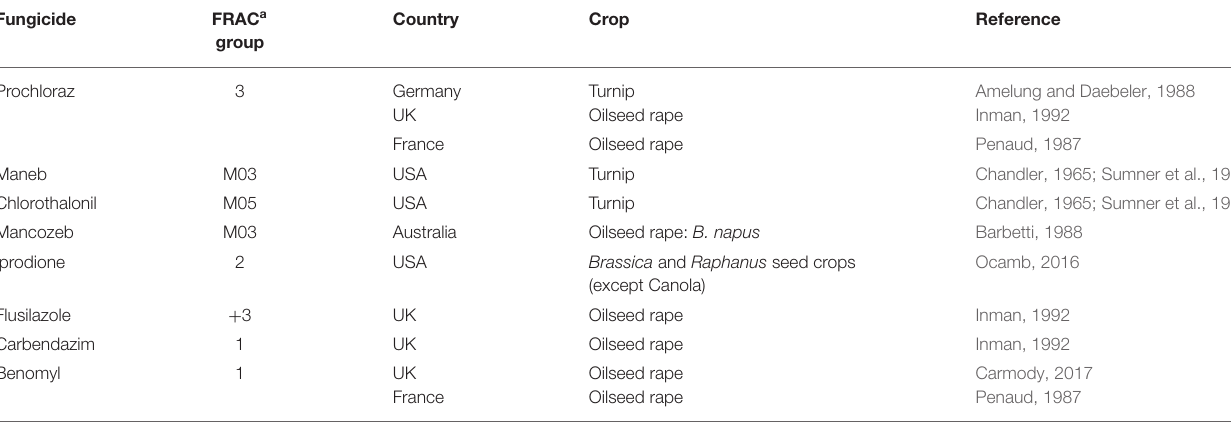
TABLE 1 | Fungicides reported as effective in controlling white leaf spot disease on Brassica crops. Fungicide